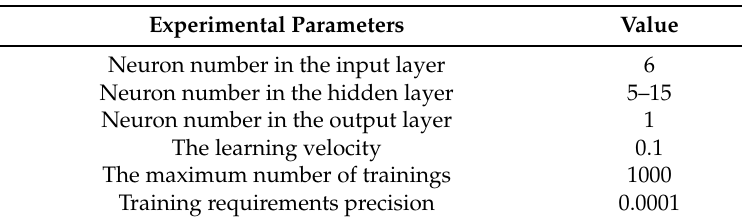
Table 2. The experiment parameters of BP.